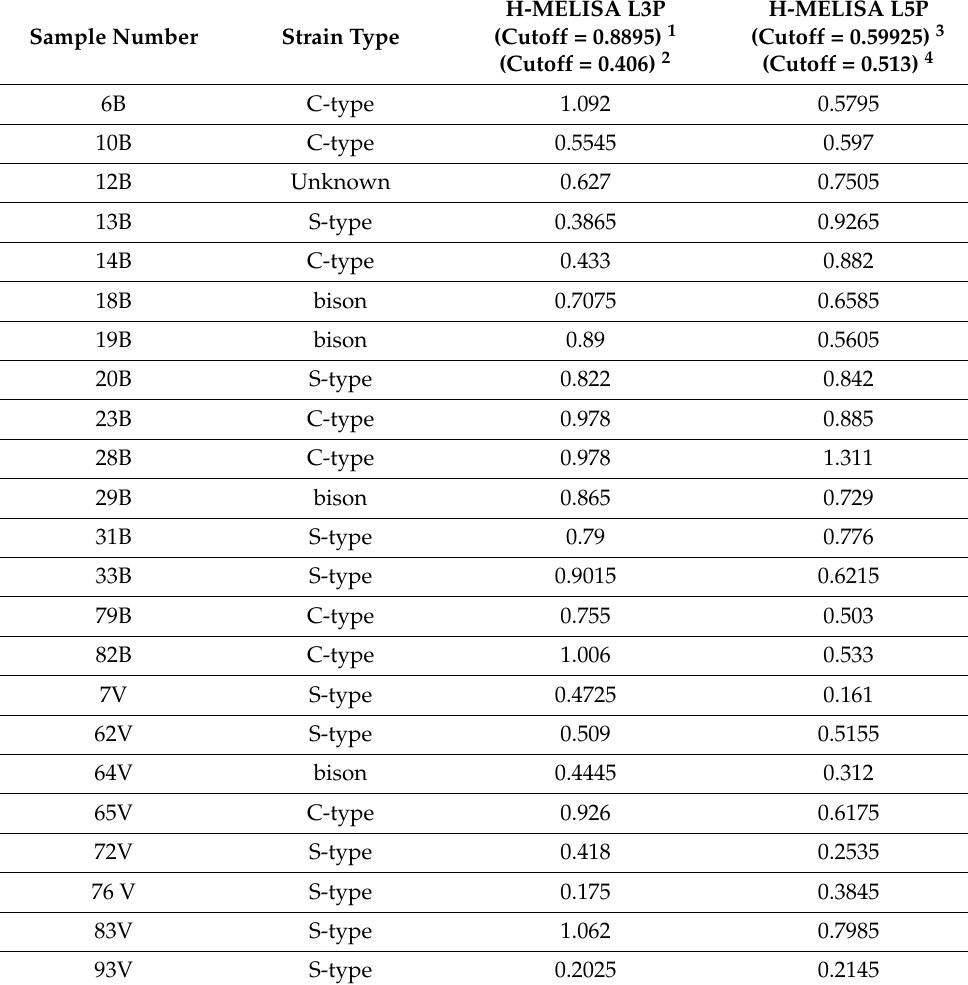
Table 5. The distribution of 15 BTMs and 8 individual milk (MIF) samples, based on the types of MAP identified therein by strain-typing analysis and H-MELISA-L3P/L5P